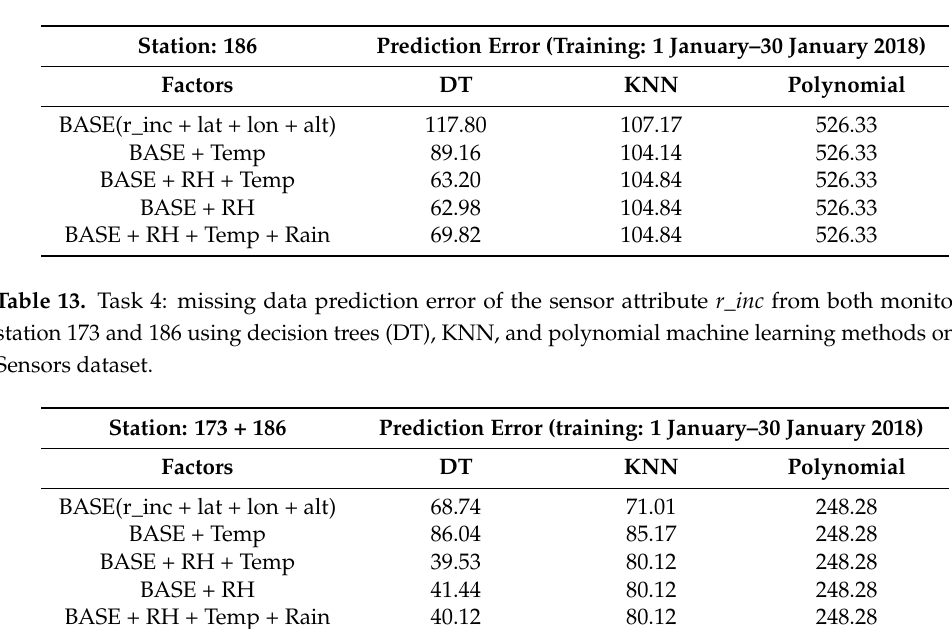
Table 12. Task 4: missing data prediction error of the sensor attribute r_inc from monitoring station 186 using decision trees, KNN, and polynomial machine learning methods on IoT Sensors dataset.